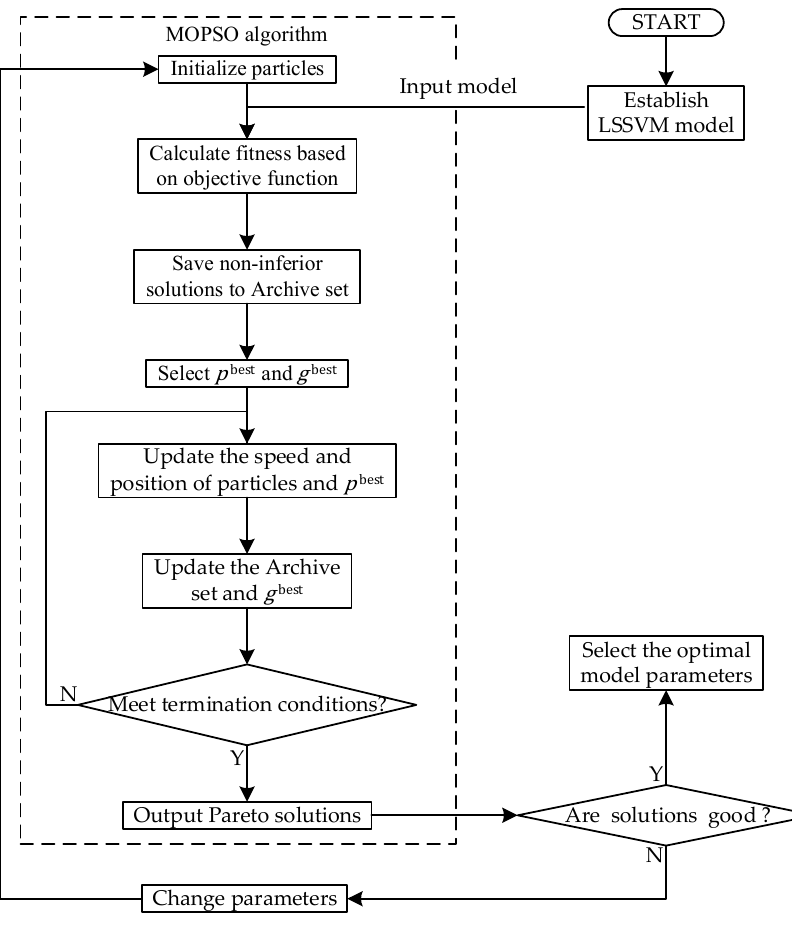
Figure 8. Schematic diagram of the multi-objective optimization process. The 48 test values on F S and V were divided into 10 data groups after being randomly sorted. The 9 data groups were chosen at random to serve as a training sample for the LSSVM surrogate model to obtain the predicted values of the remaining data group. The procedure was then carried out 9 times to produce the predicted values for each data